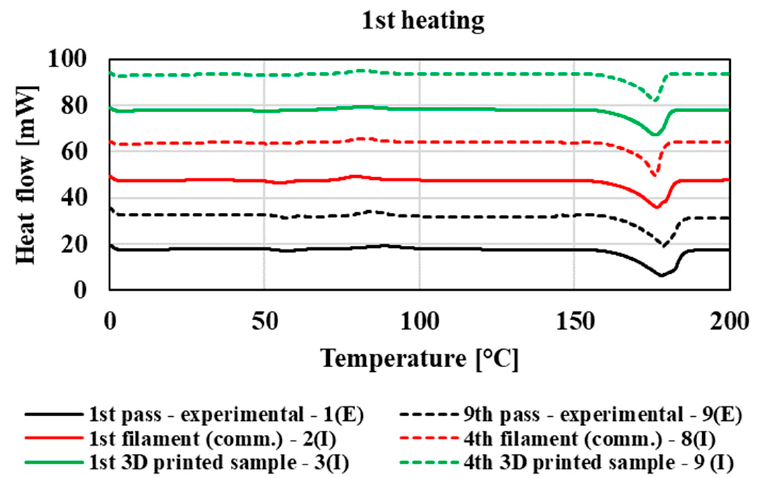
Figure 12. DSC thermogram of 1st heating for experimental and commercial type polymeric material.